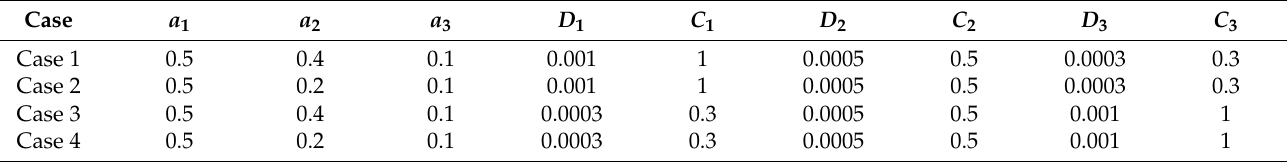
Table 3. The parameters in FEA